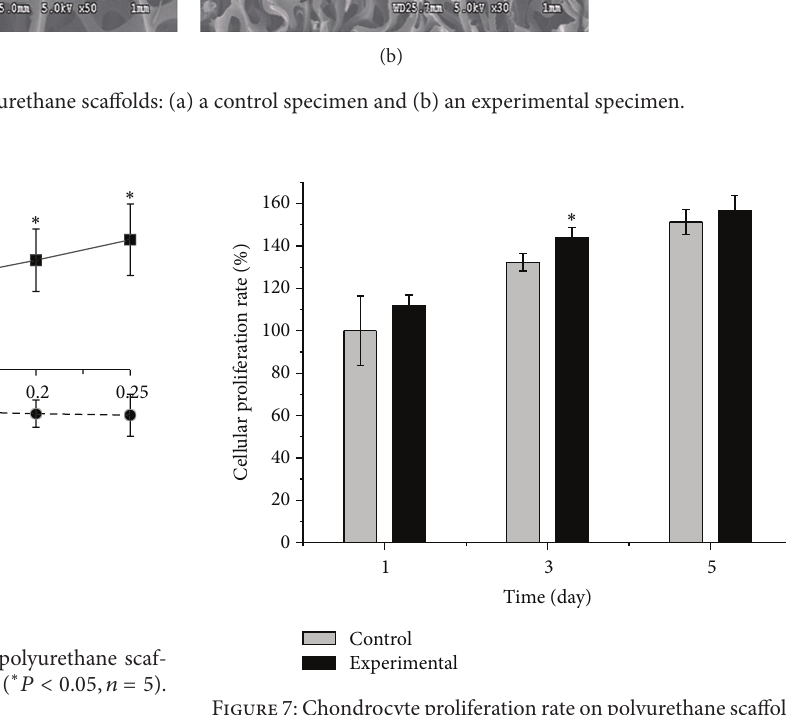
Figure 7: Chondrocyte proliferation rate on polyurethane scaffolds. Values were normalized ( 𝑛 = 5 , ∗ 𝑃 < 0.05